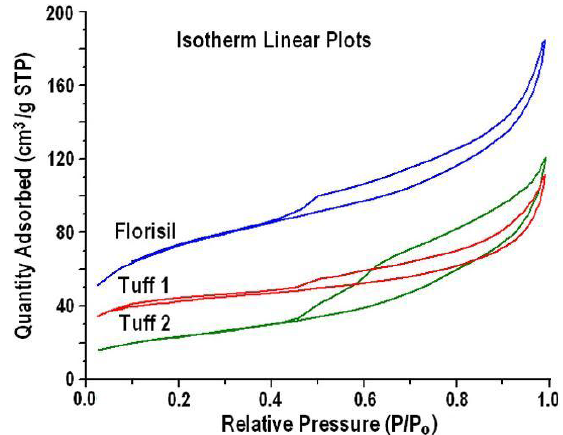
Figure 1. The N adsorption–desorption isotherms at 77 K of the 2 studied